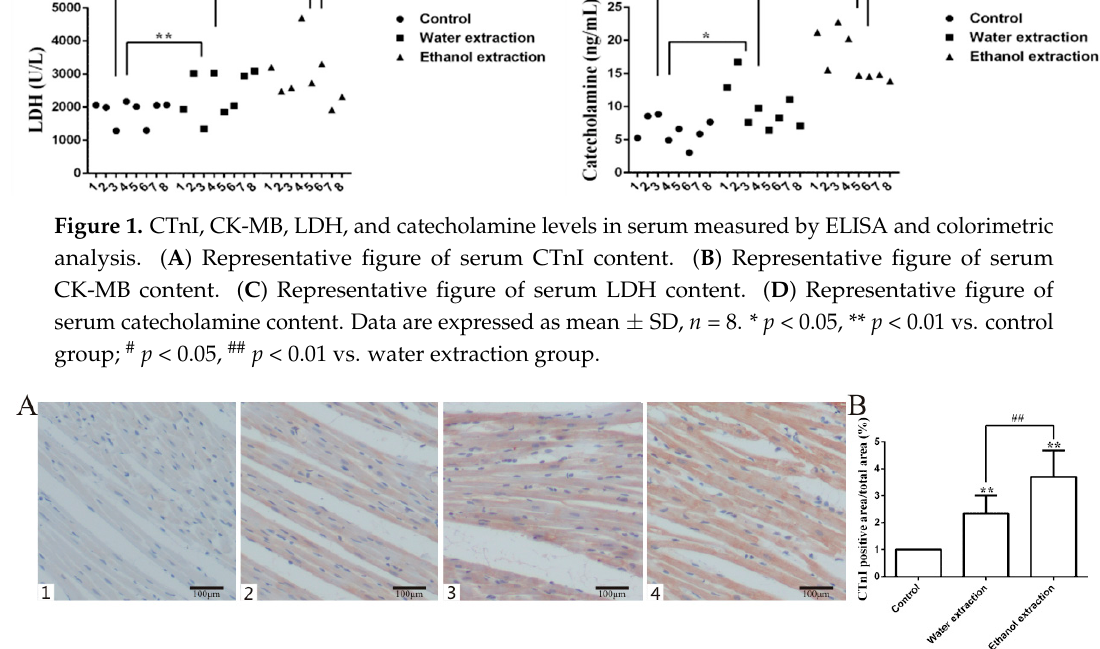
Figure 2. CTnI expression levels in the heart tissues in control, water extraction, and ethanol extraction groups. ( A ) Representative figure of CTnI immunohistological staining in heart (200×); 1: Negative group; 2: Control group; 3: Water extract group; 4: Ethanol extract group. ( B ) Statistic results of CTnI immunohistological staining ( n = 8); data are expressed as mean ± SD. ** p < 0.01 vs. control group; ## p < 0.01 vs. water extraction group.